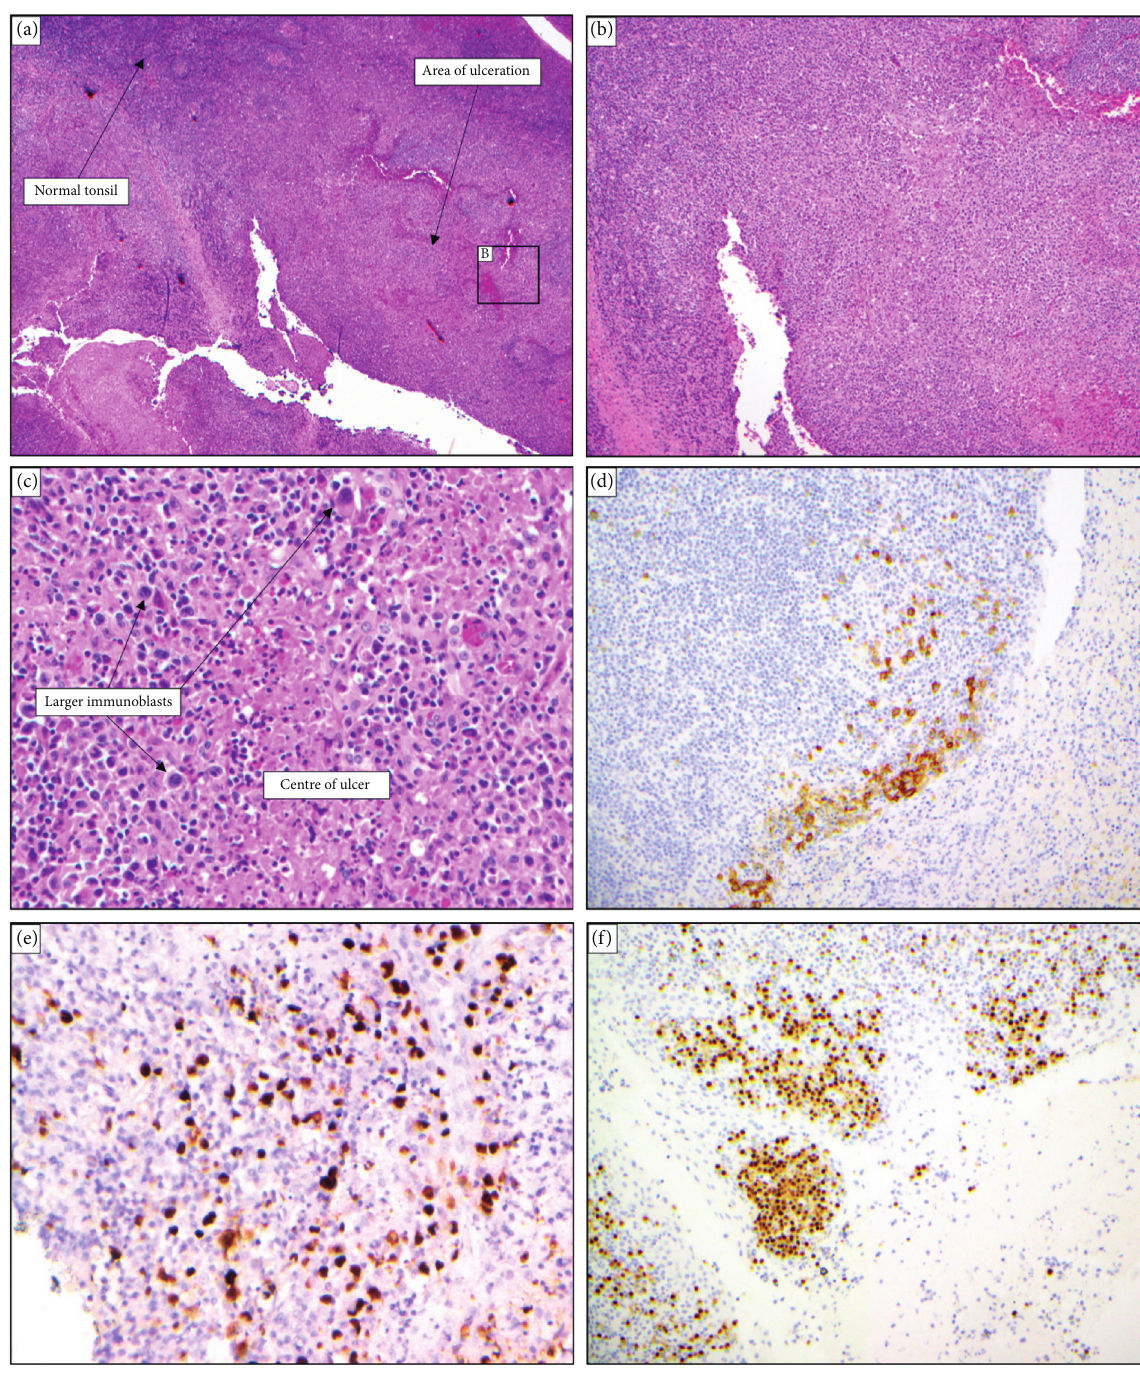
Figure 1: Histopathology demonstrating the normal tonsillar tissue with areas of deep ulceration at 4x (a) and 10x (b) magnification. At 40x magnification, the large immunoblasts and the occasional Reed–Sternberg-like cells are demonstrated in the centre of the ulcer (c). The larger immunoblasts demonstrated positive staining for CD-30 (d), EBERish (e), and MUM-1 (f). Table 1: Differentiating characteristics of EBV +ve DLBCL and